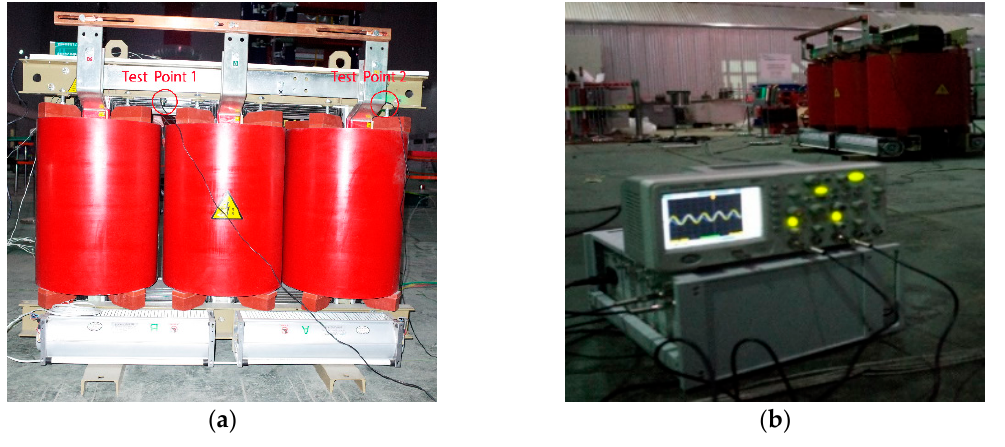
Figure 2. ( a ) Position of vibration-acceleration sensor; ( b ) field experiment.